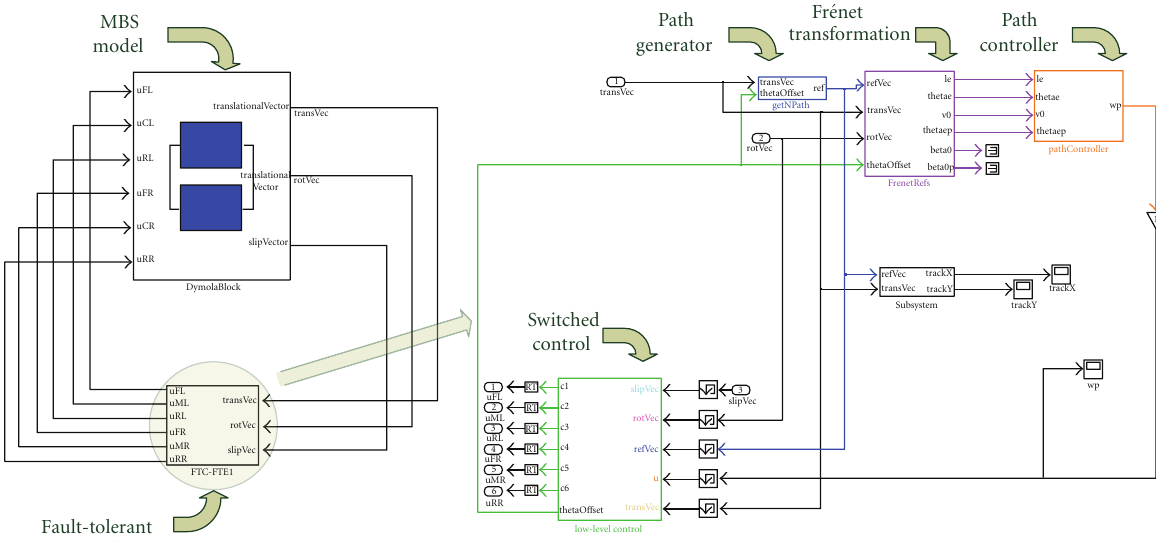
Figure 15: Matlab/Simulink implementation of the control system in Figure